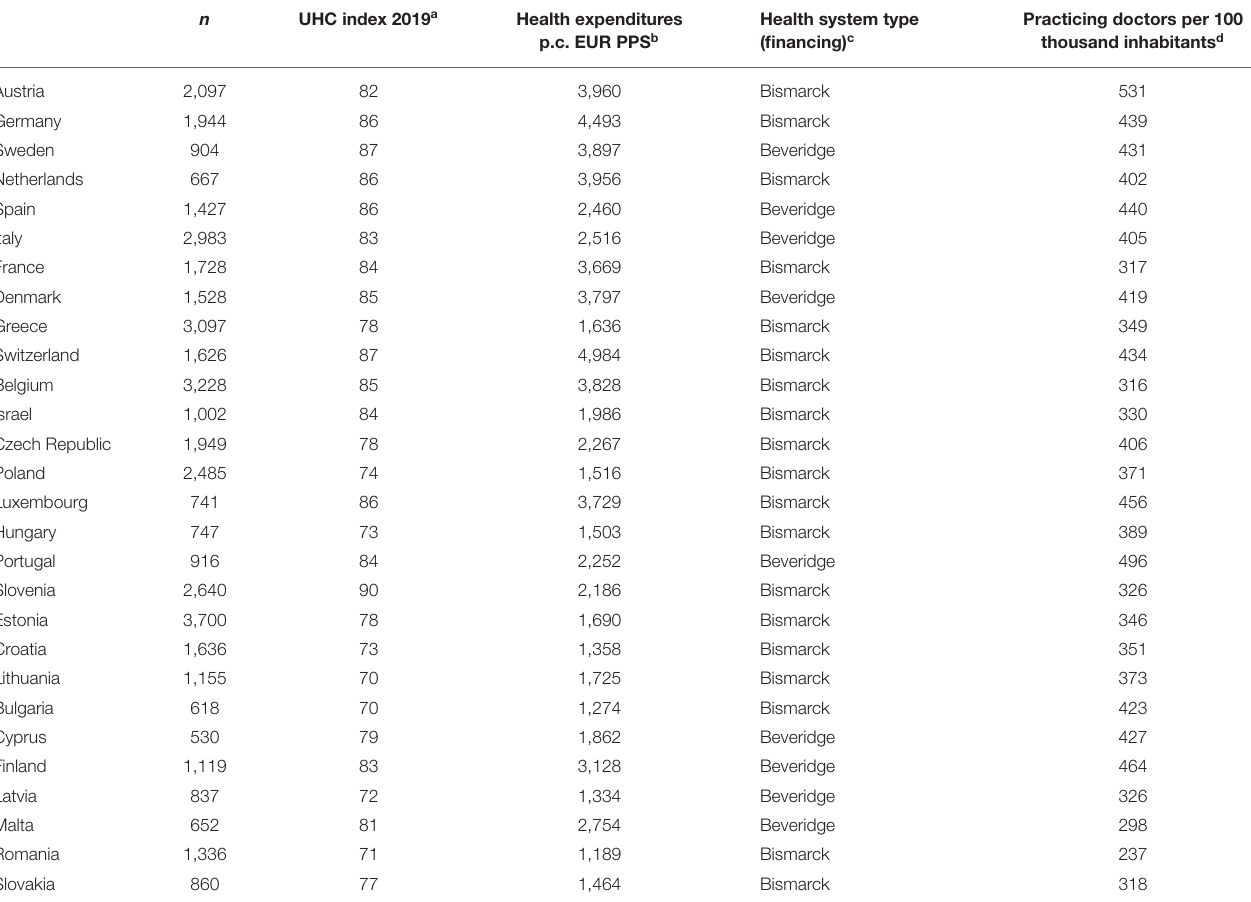
TABLE 3 | Health system characteristics of countries in the sample.